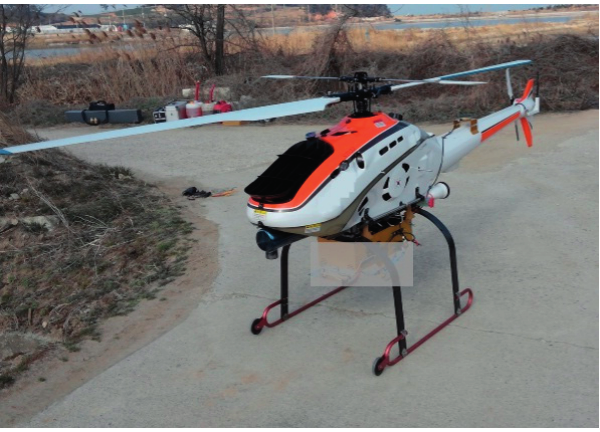
Figure 12. The unmanned helicopter and navigation sensor used for the flight